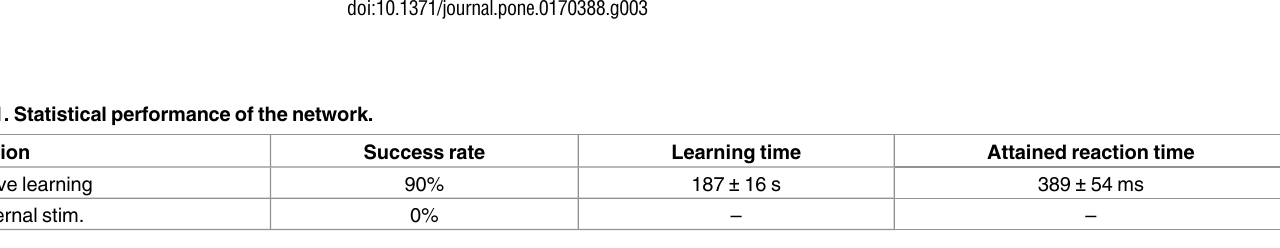
Fig 3. Evolution of the reaction times of 2 successful neural networks at the selectivelearning task. 20 networkswere simulated,18 of which successfully learnedthe task (Table 1). Red lines represent when there was no responsefrom the network. A learningcurve is clearly visible.